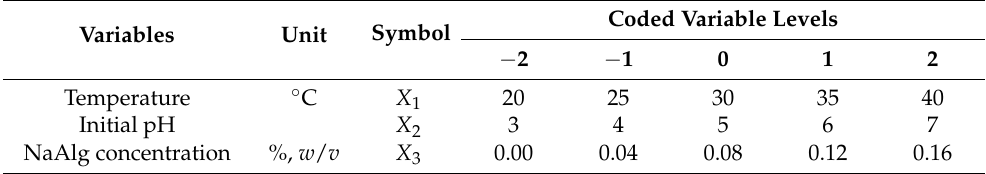
Table 1. Variables and the coded variable levels of the central composite design under experimental conditions. Variables Unit Symbol